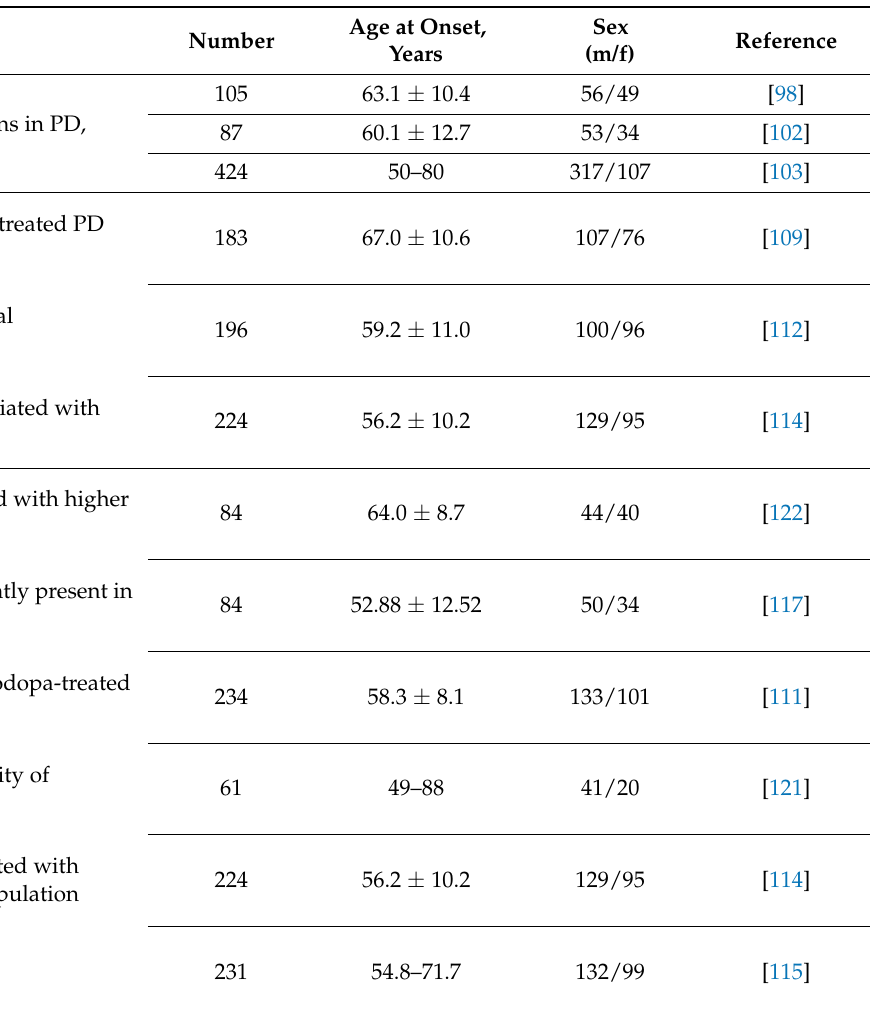
Table 2. Summary of main genes related to PDP